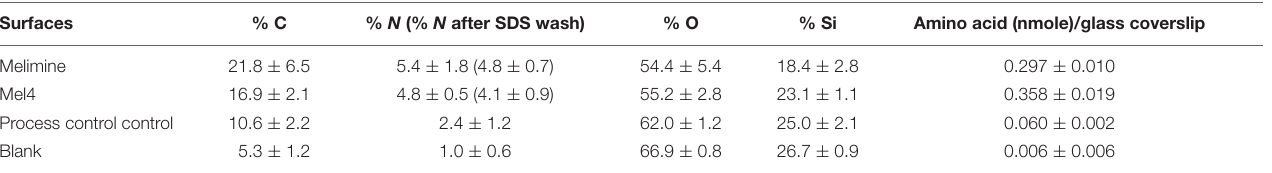
TABLE 1 | Elemental composition and amount of peptide (amino acids) bound to glass surfaces. Surfaces % C % N (% N after SDS wash) % O % Si Amino acid (nmole)/glass coverslip